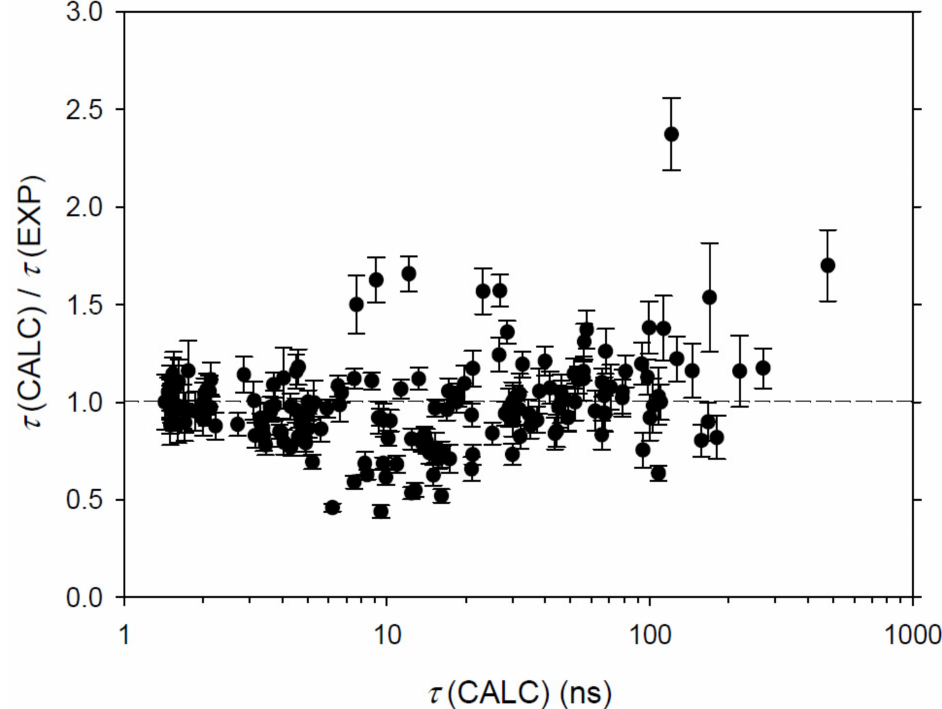
Figure 3. Comparison between the calculated and experimental radiative lifetimes ( τ ) obtained for all the lanthanide ions considered in our previous works. The calculations were performed using the HFR + CPOL method while the measurements were carried out by TR-LIF spectroscopy. The dashed line indicates